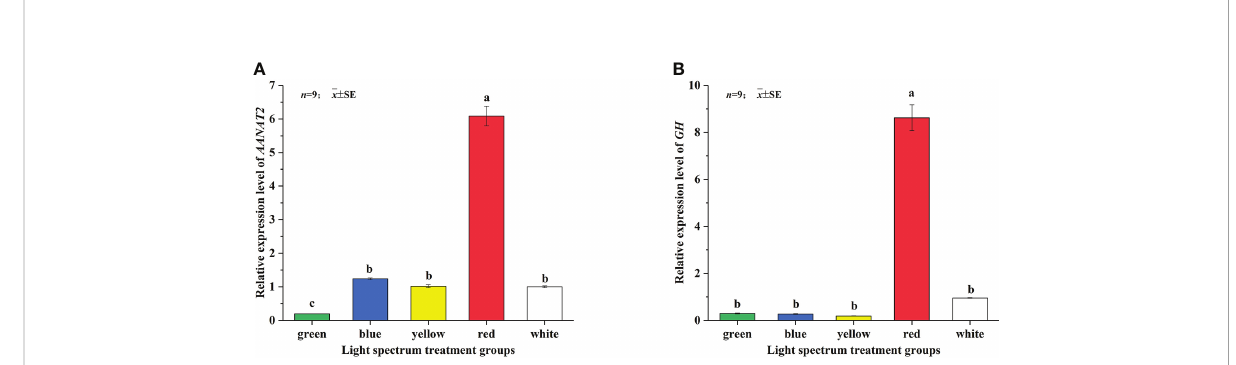
FIGURE 1 Effects of different LED spectra on relative expression of GH (A) and GHRH (B) genes in juvenile Takifugu rubripes . In the same column diagram, values with same small letter superscripts mean no signi fi cant differences ( P >0.05), different small letter superscripts mean signi fi cant sdifferences ( P <0.05).